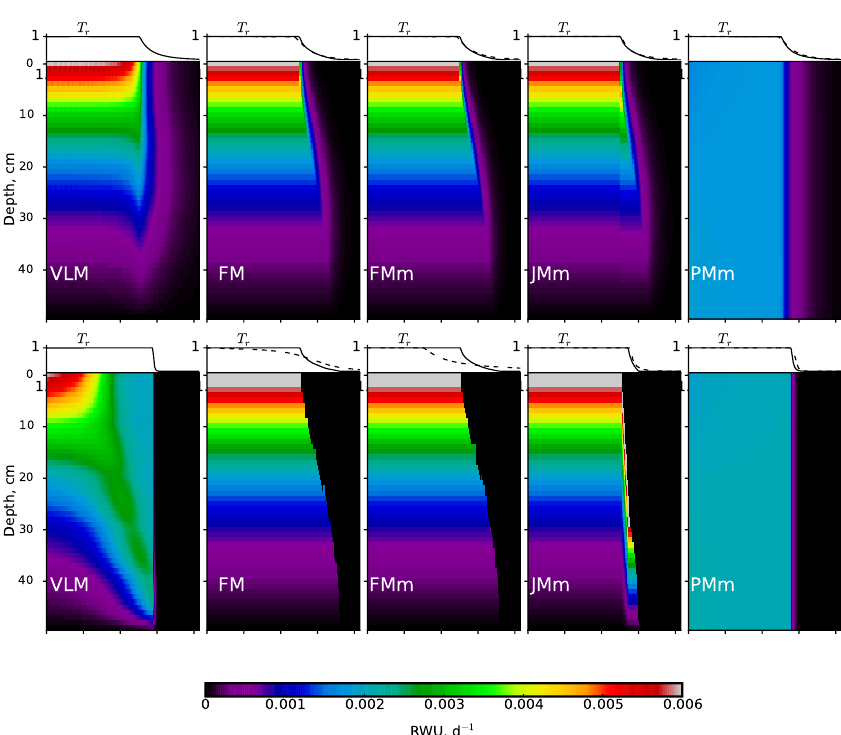
Figure 11. Time–depth root water uptake (RWU) pattern and relative transpiration ( T r ) simulated by the SWAP model in combination with the De Jong van Lier et al. (2013) reduction function, and evaluated empirical models optimized performed T r instead of RWU for loam soil and low (first line of the plots) and high (second line of the plots) root length density and T p = 1mmd − 1 . The dashed lines indicate T r when the models were optimized with